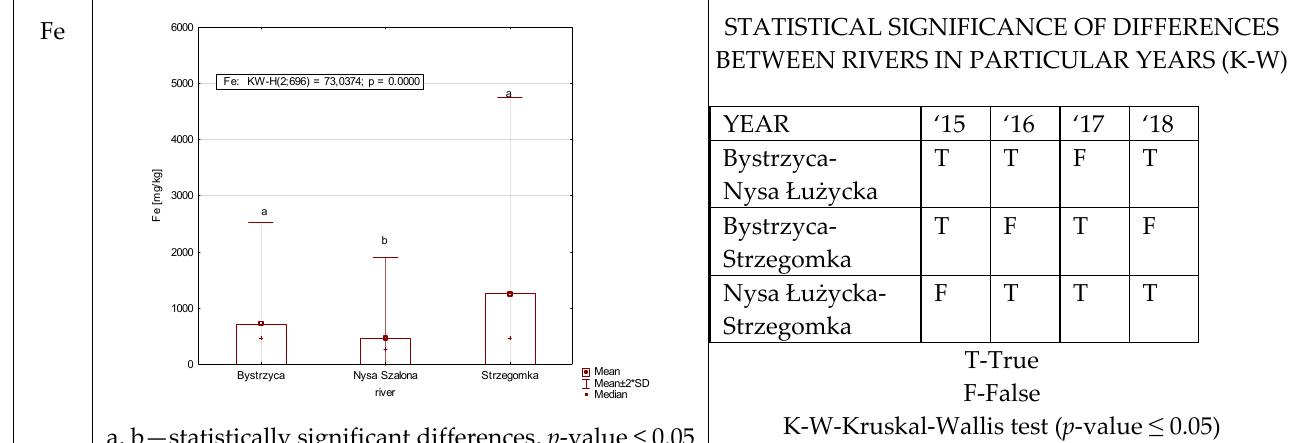
Figure 8. Fe concentration in plants from rivers across 29 sites depending on river (graph to the ( left )) and by year 2015–2018 in the table to the ( right ). Statistically significant differences are marked in the graph with letters a, b and in the table these differences are shown by year between rivers—T—differences were present, F—no statistical difference ( p -value ≤ 0.05). The differences between the rivers may be noted using PCA plot. Nysa Szalona and Strzegomka were the most different in respect of the examined parameters, and Bystrzyca had parameters intermediate between the other rivers (Figure